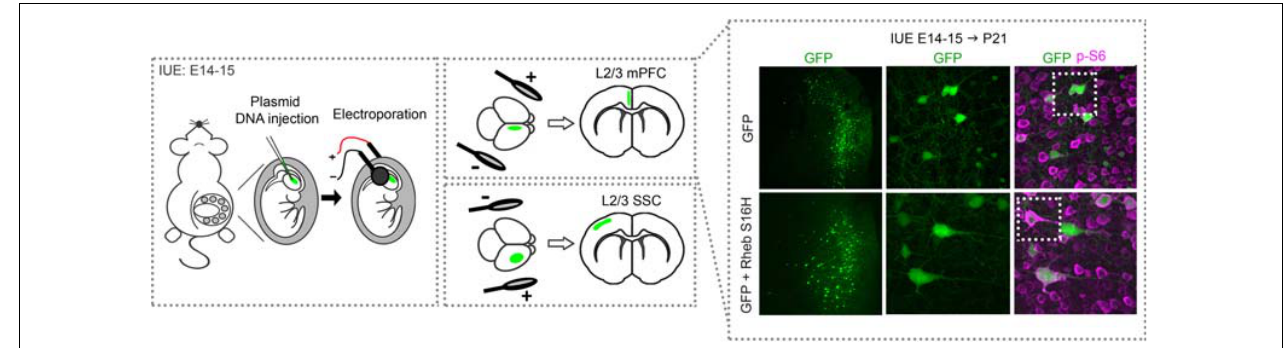
FIGURE 2 | Schematic diagram of in utero electroporation and example of electroporated cortices. Rodents are electroporated at E14–15 ( ± 0.5), which targets L2/3 cortical pyramidal neurons. Briefly, plasmid DNA is injected into the lateral ventricles and electrical pulses are passed through to electroporate the plasmid into neural progenitor cells (i.e., radial glia). The position of the electrodes that generate the pulses direct the plasmid into the specific brain region of interest, e.g., mPFC or SSC. An example of cortices from mice electroporated with GFP or GFP + Rheb S16H plasmids in the mPFC are shown. Note that GFP-expressing cells are positioned in L2/3 while GFP + Rheb S16H -expressing cells are misplaced across the cortical layers. GFP + Rheb S16H -expressing cells are also larger and exhibit increased phospho (p)-S6 levels, a marker of mTORC1 activity. E, embryonic day; L, layer; mPFC, medial prefrontal cortex; SSC, somatosensory cortex.